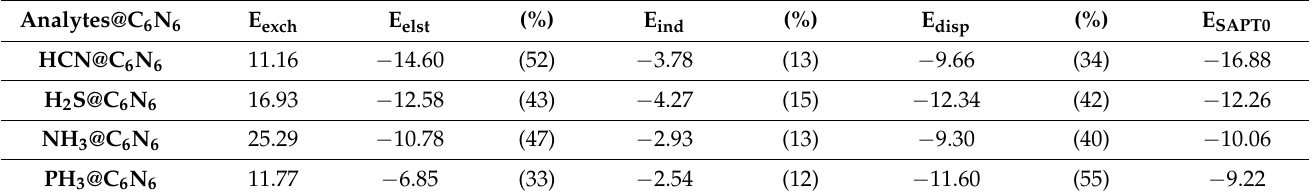
Table 1. Stabilization energies of analyte@C 6 N 6 complexes obtained through SAPT0 analyses.